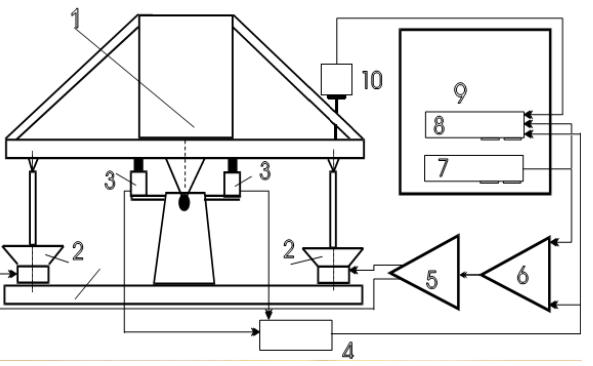
Figure 4. The principle structure of the MET calibrator of the displacement sensor.